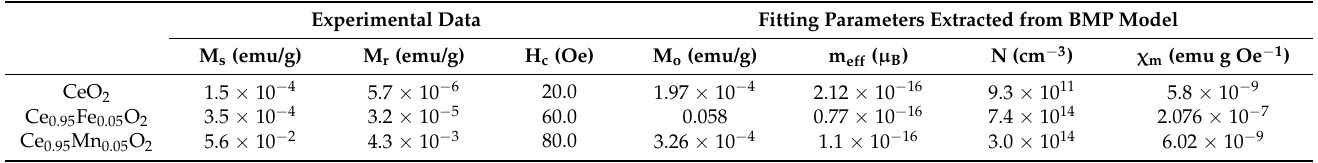
Table 2. List of parameters obtained from experimental M-H curve and fitting of the Langevin equation to find BMP and matrix contribution to the ferromagnetic